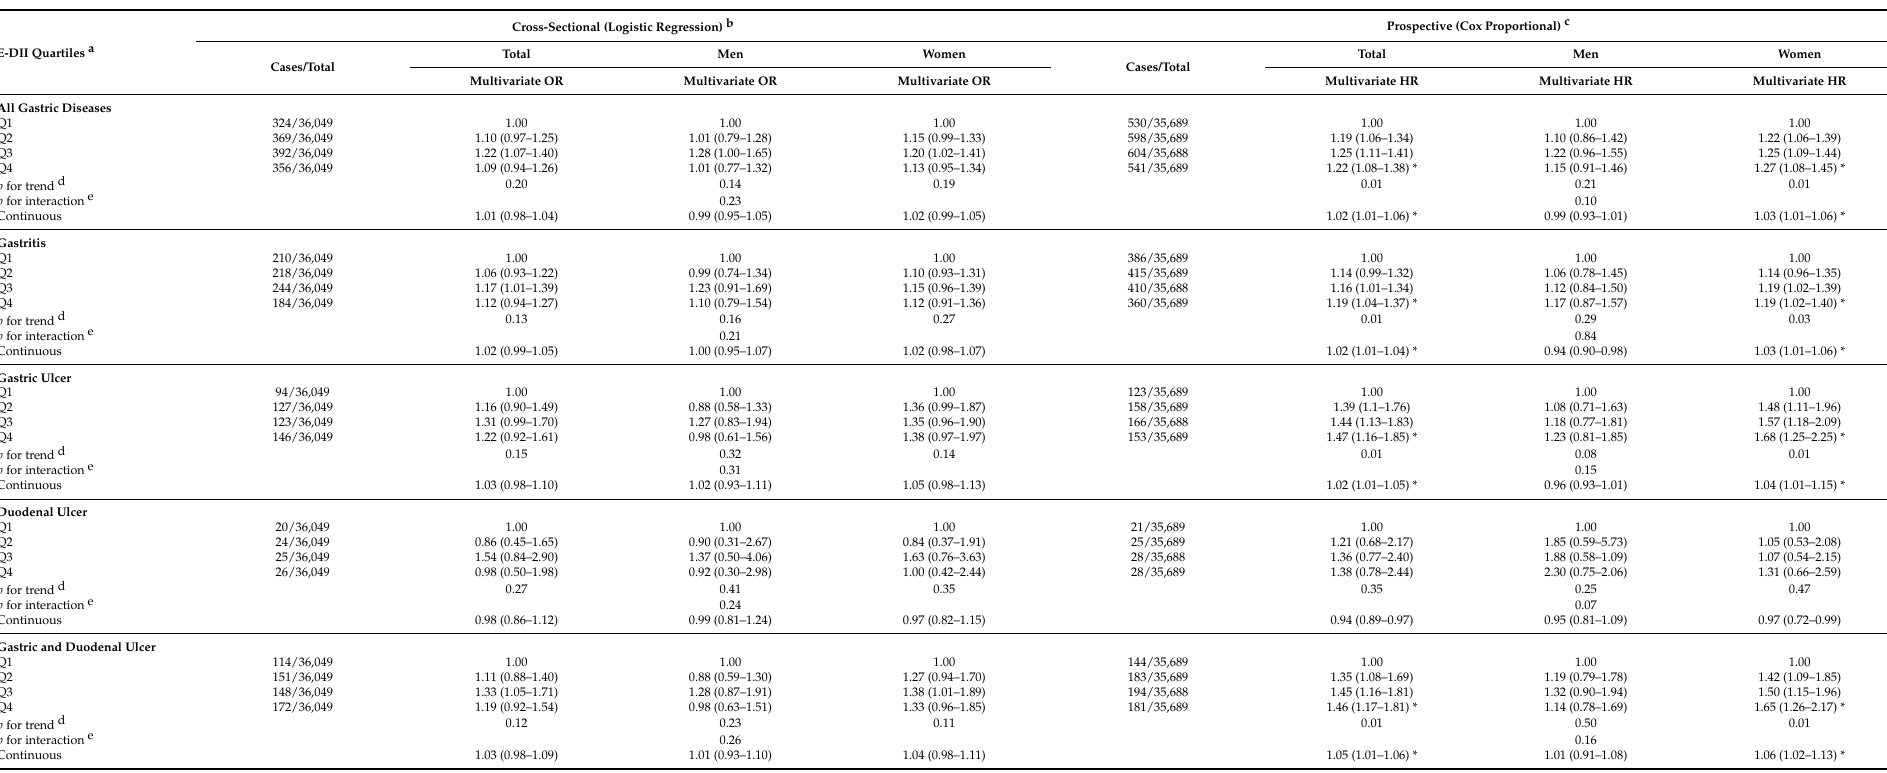
Table 2. Association between E-DII and gastric disease risk for all participants in cross-sectional analysis ( n = 144,196) and prospective analysis ( n = 142,755) of the